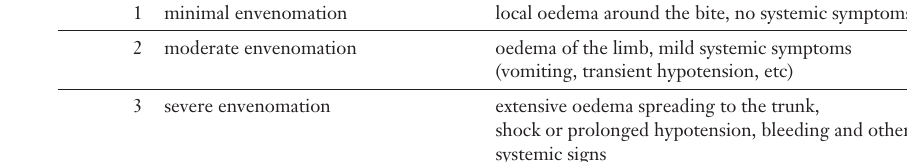
Clinical gradation after viper-bite.